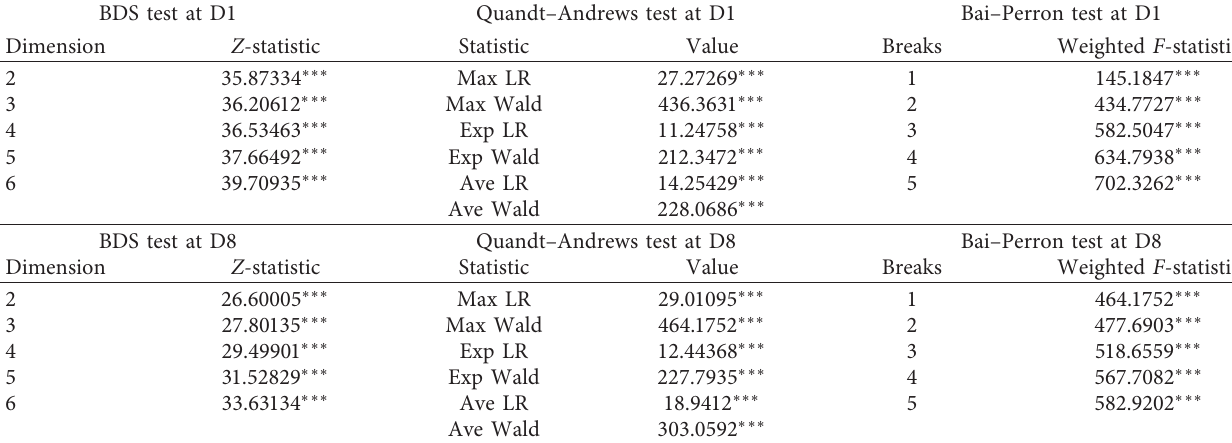
Table 6: Mutation point test at D1.